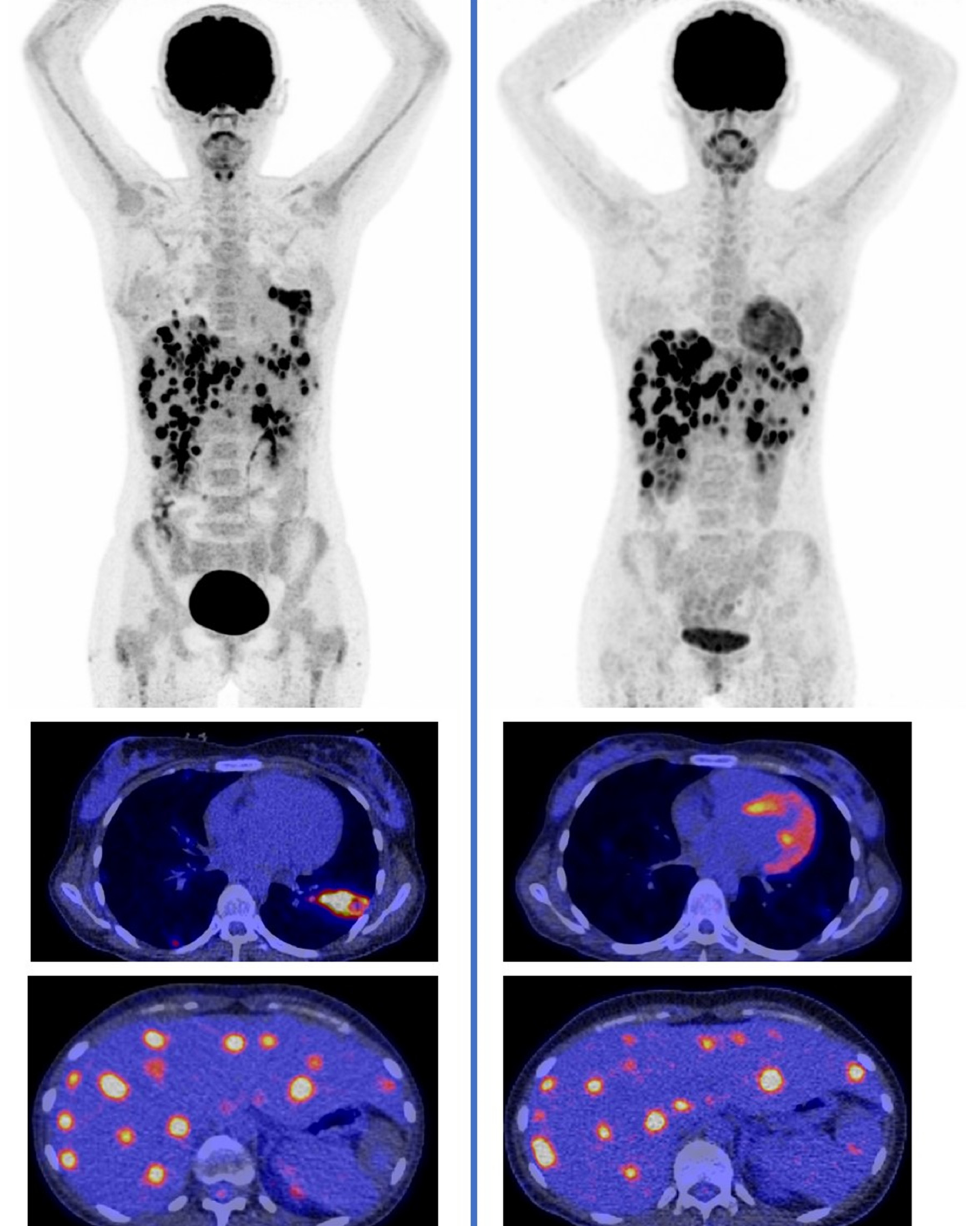
Figure 3. A 31-year-old female diagnosed with disseminated candidiasis after chemotherapy for acute lymphocytic leu- kemia. Baseline [ 18 F]FDG PET/CT ( left column) showed disease involvement in the lungs, liver, and spleen. Repeat [ 18 F]FDG PET/CT after 3 months of voriconazole and caspofungin ( right column) for treatment response